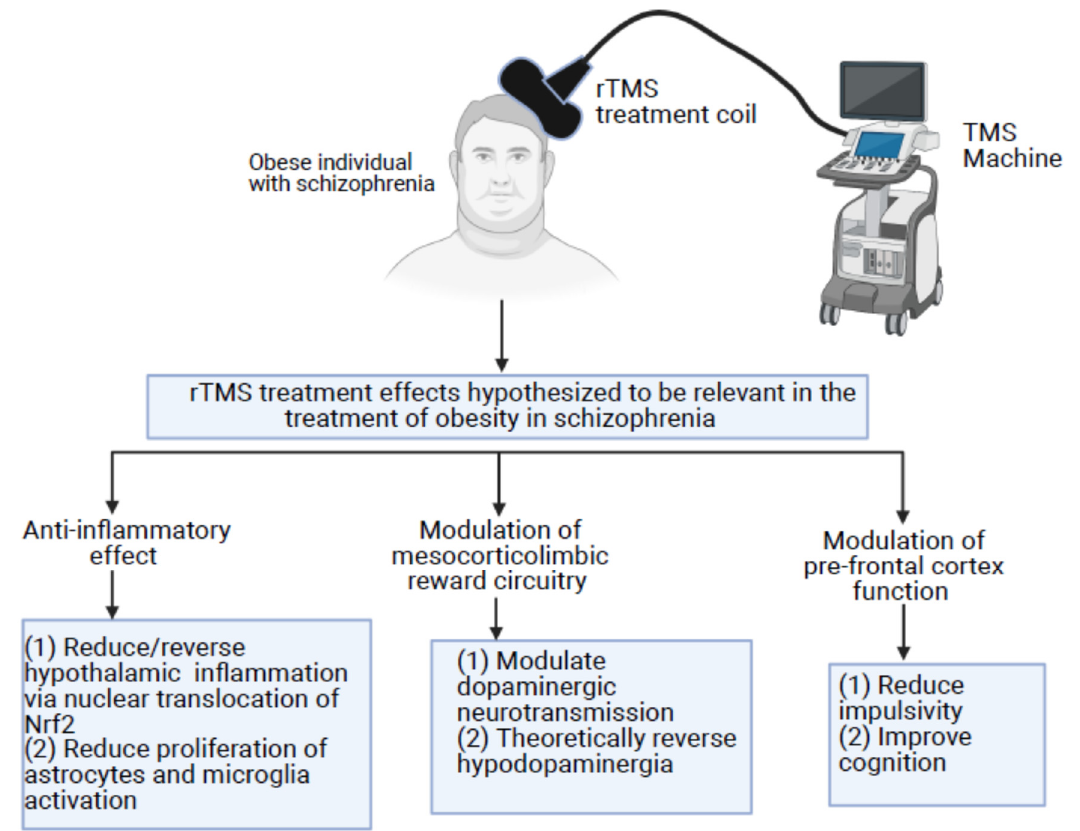
Figure 2. rTMS effects that we have hypothesized to be relevant for treating obesity in patients with schizophrenia. The documented effects of rTMS, including its anti-inflammatory effects, modulation of dopaminergic neurotransmission in the mesocorticolimbic system, and modulation of prefrontal cortex function, all have the potential to be beneficial for reducing food cravings and food consumption and lead to weight loss in patients with schizophrenia comorbid with obesity. rTMS: Repetitive transcranial magnetic stimulation; Nrf2: Nuclear factor erythroid-2-related factor 2.